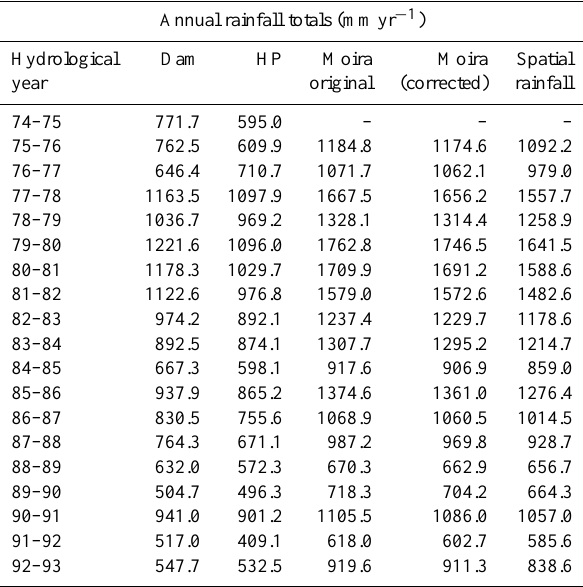
Table 4. Annual rainfall totals for the observed, corrected and cal- culated rainfall